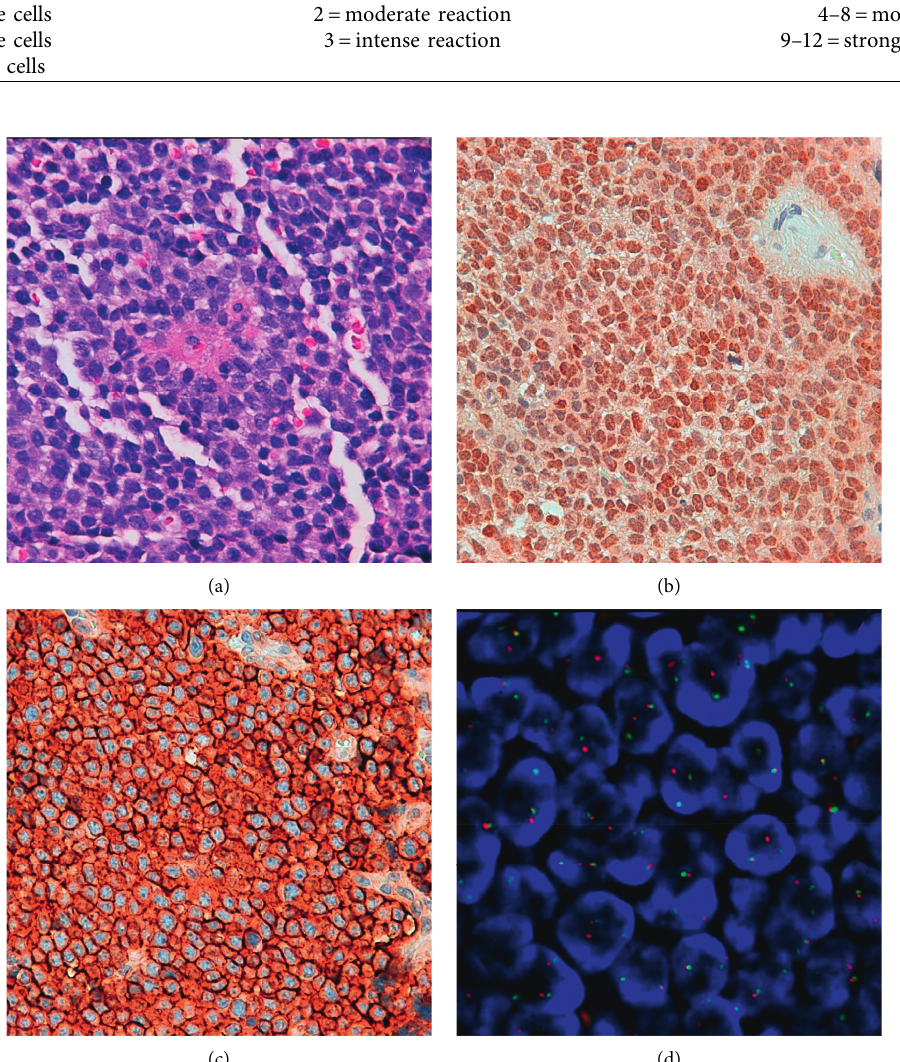
Figure 1: (a) Uniform small round tumour cells with round nuclei and scanty cytoplasm (H&E). (b) Moderate nuclear immunoreactivity for PAX8 (IHQ). (c) Strong and diffuse membranous immunoreactivity for CD99 (IHQ). (d) Split signals due to the rearrangement of EWSR1